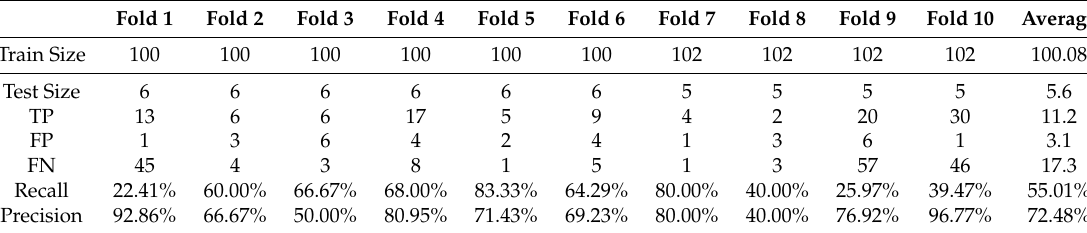
Table A8. The Results of Experiment 8: Augment the complete dataset (Dataset 4), with a larger number of epochs.